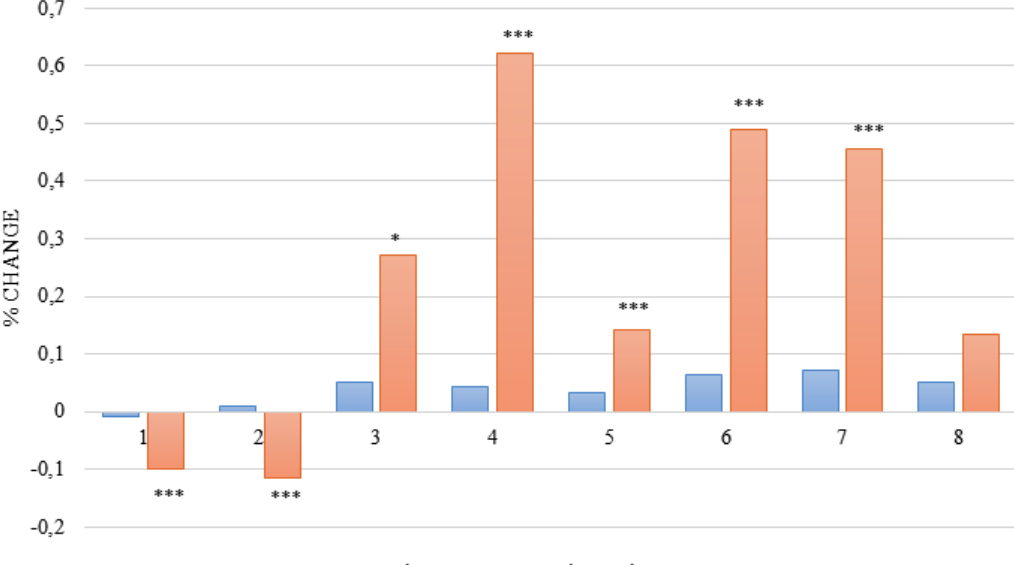
Fig. 2. The gain of indicators of functional fitness in females at the end of the research, %: Note: 1 – heart index; 2 – Robinson index; 3 – hypoxia index, c.u.; 4 – Skibinsky index, c.u.; 5 – LFSсs; 6 – LFSrs; 7 – LPH; 8 – body type evaluation;